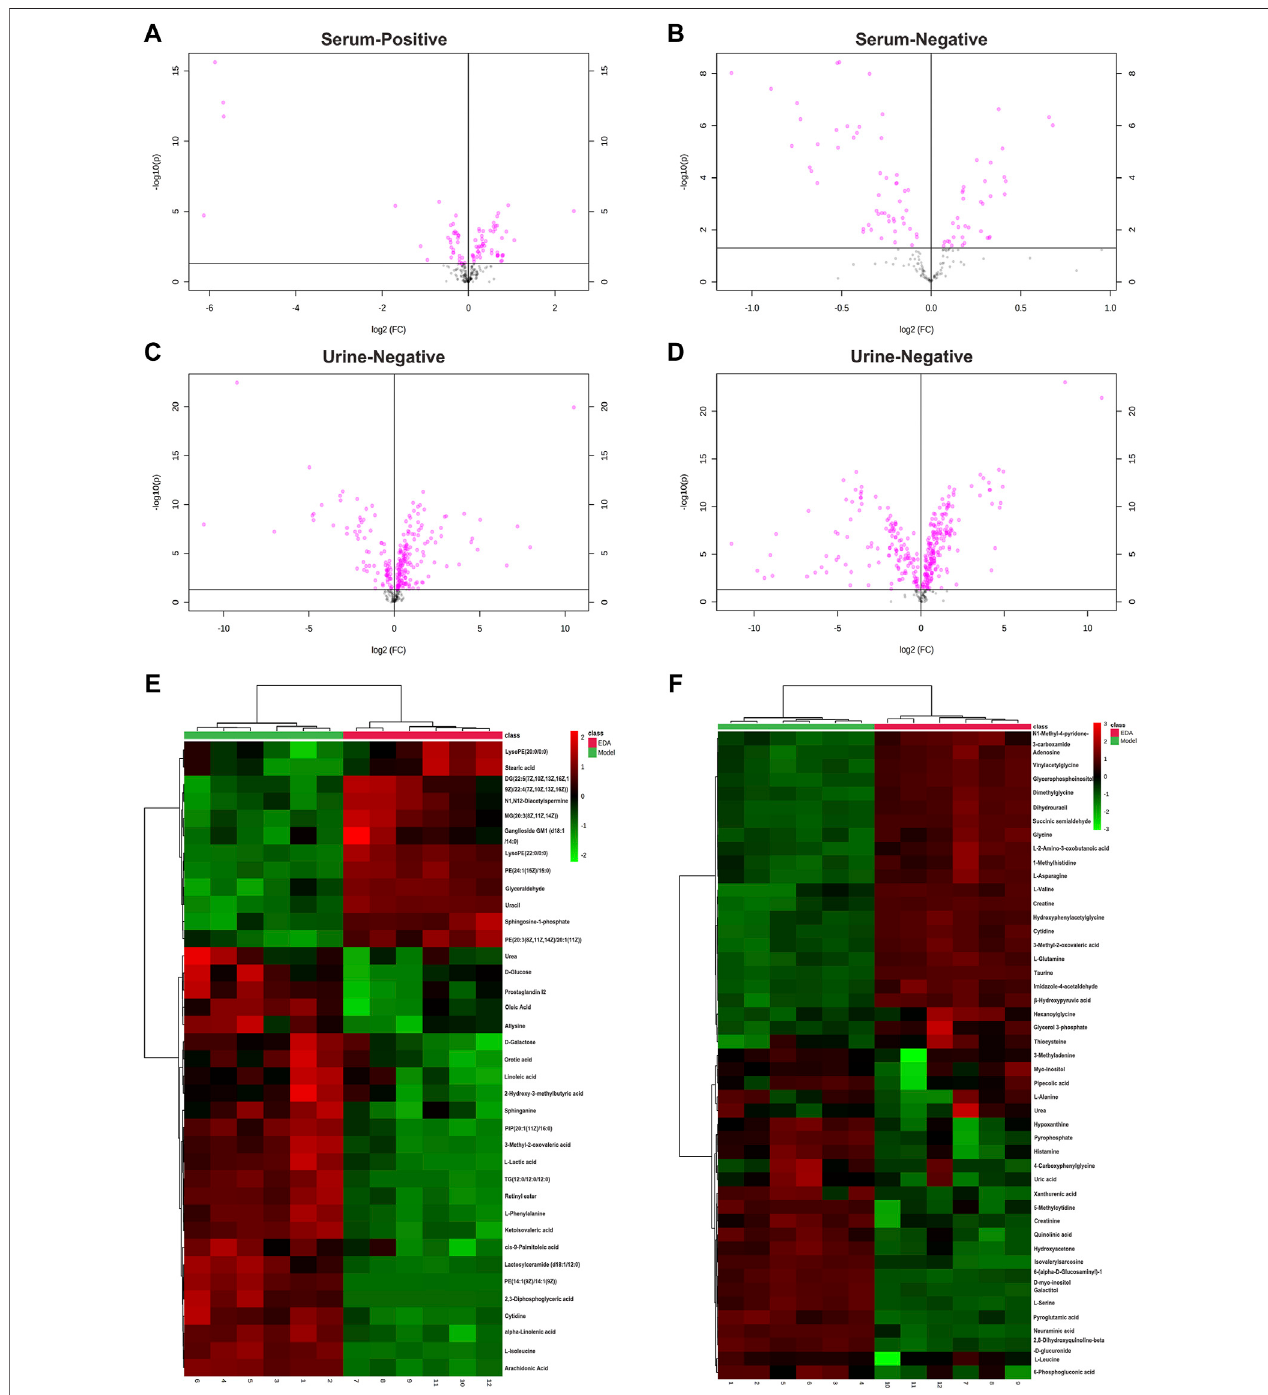
FIGURE 3 | Volcano plot and heatmap of the differential endogenous metabolites between the model and EDA group in serum and urine. (A – D) Volcano plot of modelandEDAgroup. (E) HeatmapofthedifferentialendogenousmetabolitesbetweenthemodelandEDAgroupinserum. (F) Heatmapofthedifferentialendogenous metabolites between the model and EDA group in urine. Red represented the metabolites in high abundance; green represented the metabolites in low abundance.